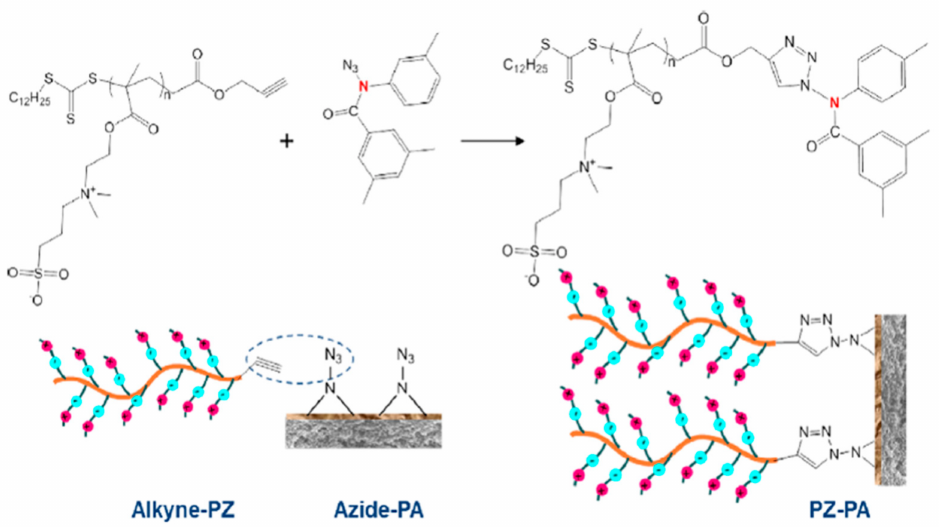
Figure 9. Click chemistry of azide–PA and alkyne–polyzwitterions (PZs) with their respective chemical structure shown on